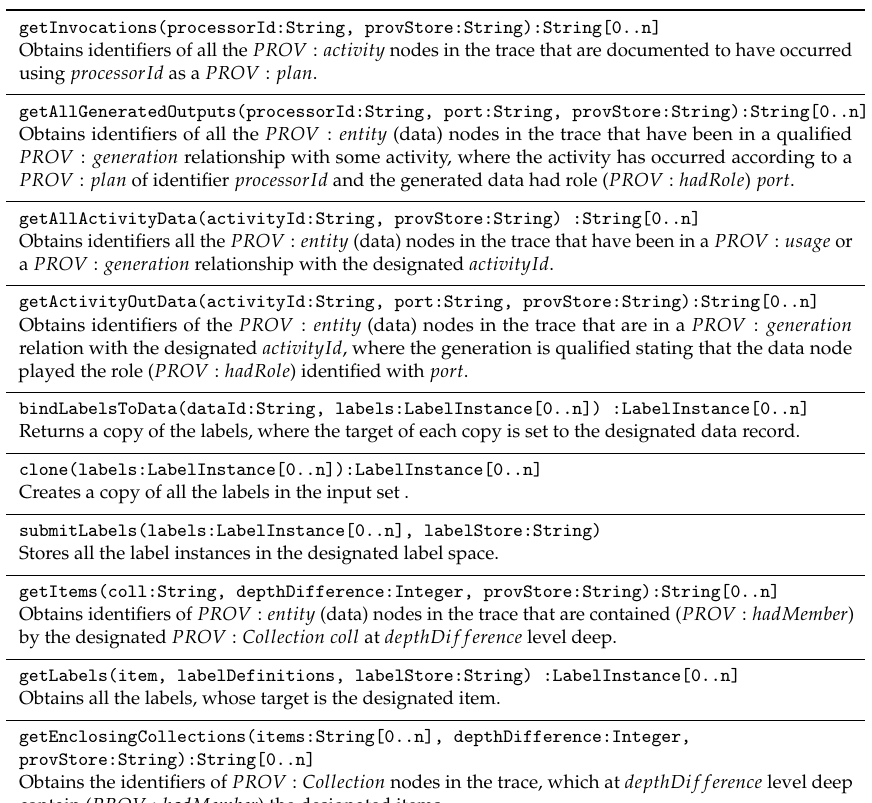
Table A1. Auxiliary methods used for annotating PROV compliant